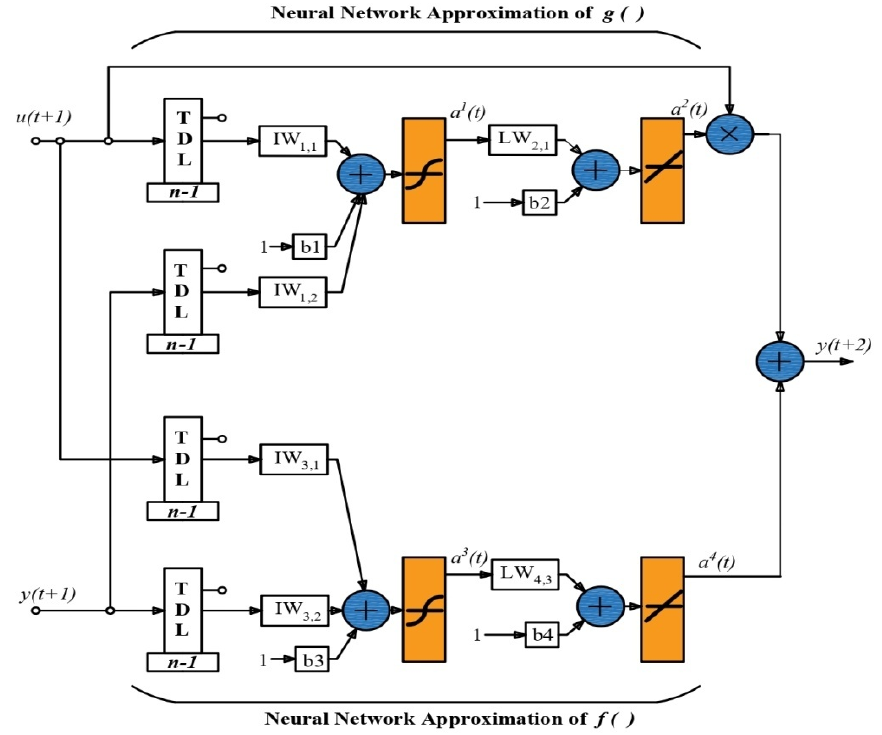
Figure 4. Neural Network Structure.